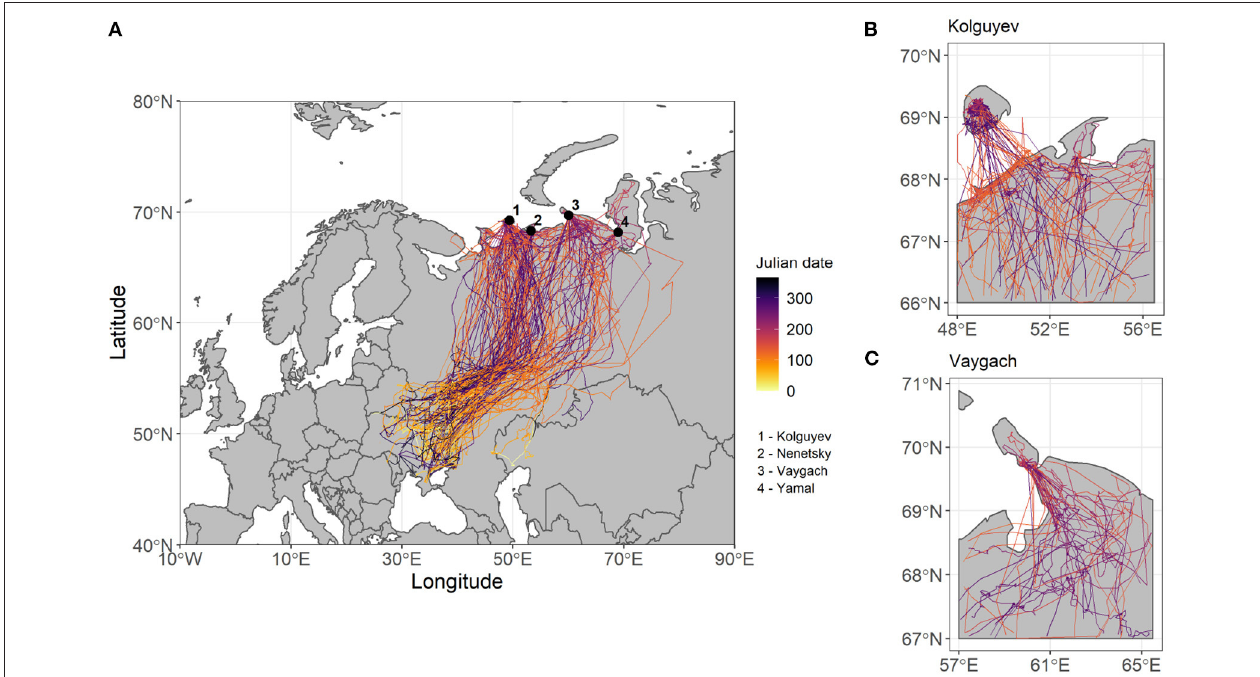
FIGURE 2 | (A) GPS trajectories of 43 rough-legged buzzards (133 annual tracks). The color gradient represents Julian date. Locations of the study sites are marked with black dots. (B) Zoomed in plot of Kolguyev Island and (C) Vaigach Island.